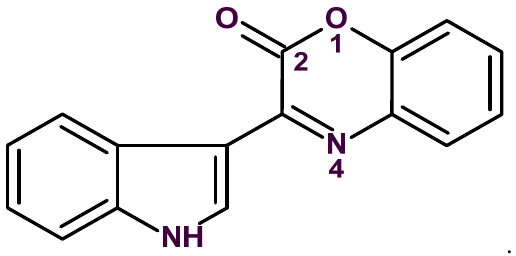
Figure 17. Structure of the natural product cephalandole A ( 21 ).